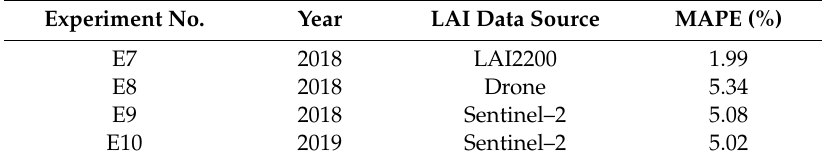
Performance of SIMRIW–RS based on a 5-year average historical satellite-derived weather